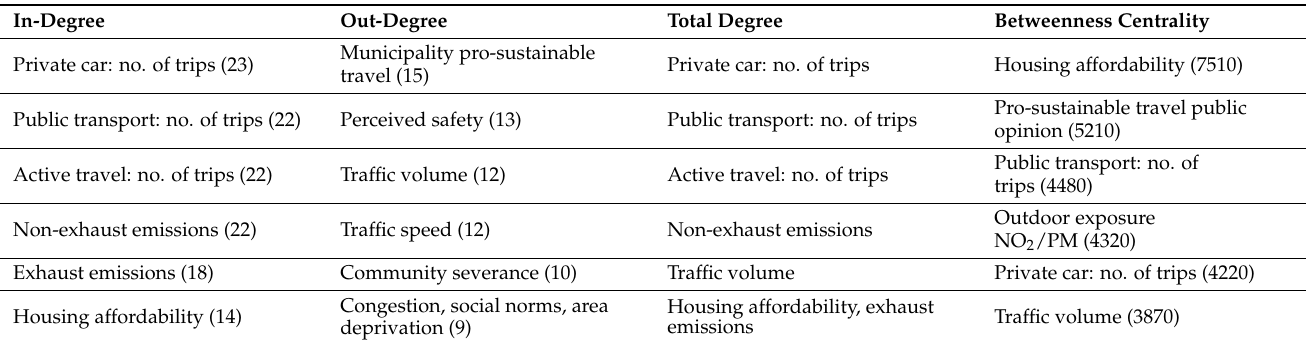
Table 5. Network centrality analysis results for the systems map showing the 6 highest-scoring map factors for 4 network measures. Values of each centrality measure for the factors listed are shown in